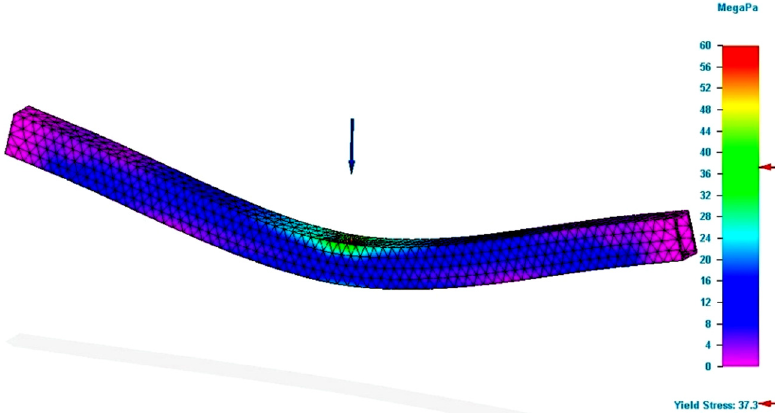
Figure 5. Results of simulation process for P_R12_T specimen (Von Mises stress).